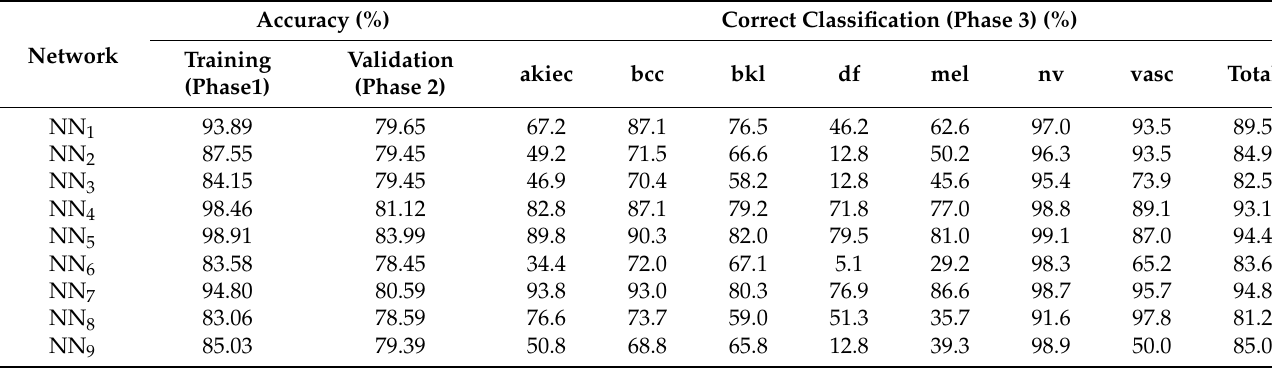
Figure 17. The resulting Weight matrix [ W ]. Table 3. The performances obtained for the singular